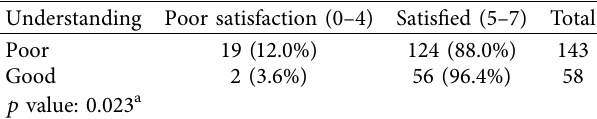
Table 4: Objective understanding and